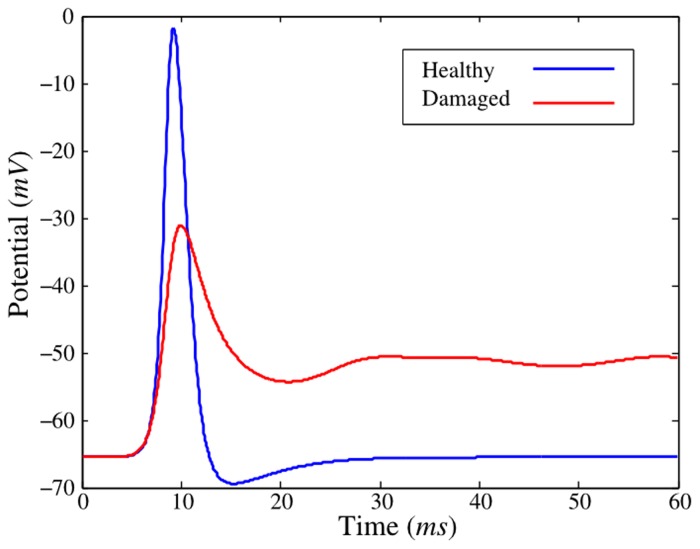
APs propagation for healthy and damaged axons.The decrease in the potential corresponds to a mild axial macroscopic strain (25%) at fast axial strain rate (∼ 400 s
−1), see Ref. [11] for more details.